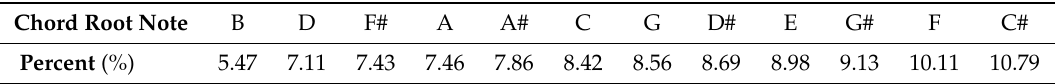
Figure 6. Distribution graph of the chord types in the Guitarset dataset. Here, “other” includes 27 classes of the chord with a duration of 1–9 s. Table 2. Root Note Distribution.